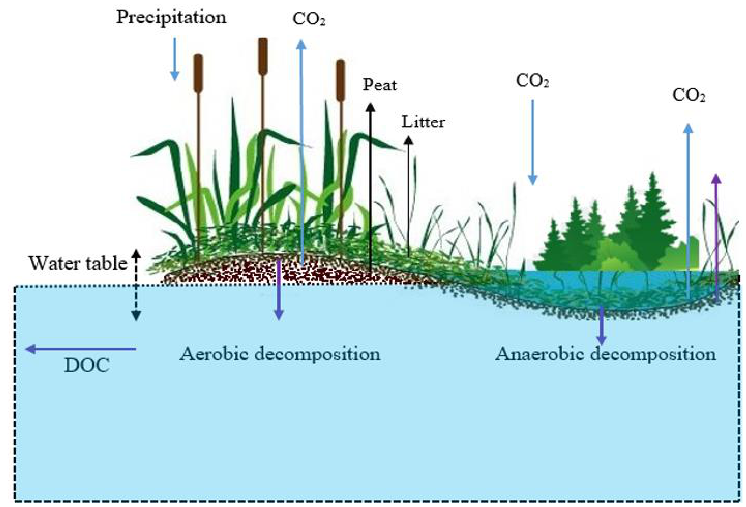
Figure 3. Conceptual model of CO 2 emission processes in the Wetlands.